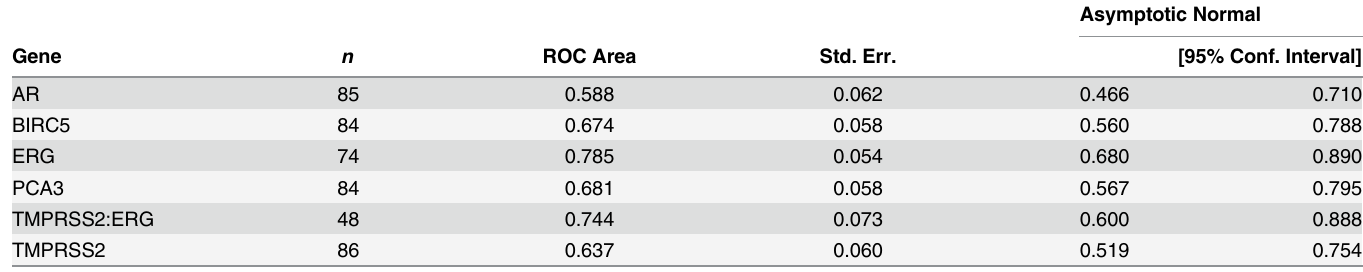
Table 4. ROC analysis of biopsy negative versus biopsy positive patients using urinary EV